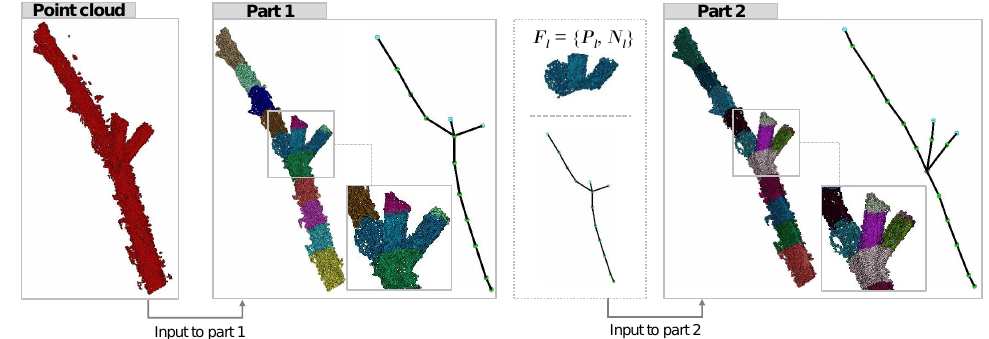
Figure 1. Overview. As input, we are provided a 3D point cloud of a plant architecture. A partial point cloud of the region around a branch point (fork) is shown. In Part 1, we compute its skeleton. Each color represents points and normal vectors that belong to a node in the graph. In Part 2, the geometry and branch angles around a fork are refined to better match the underlying plant